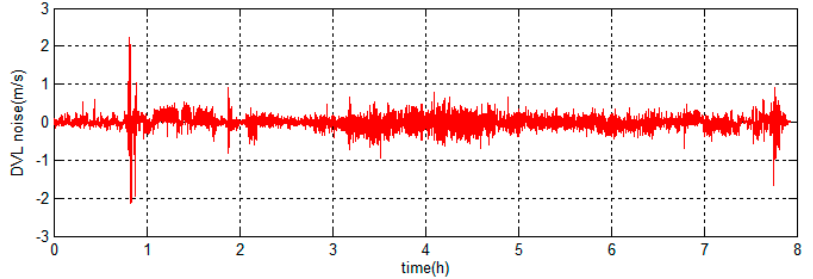
Figure 17. DVL output errors of the ship-mounted experiment.